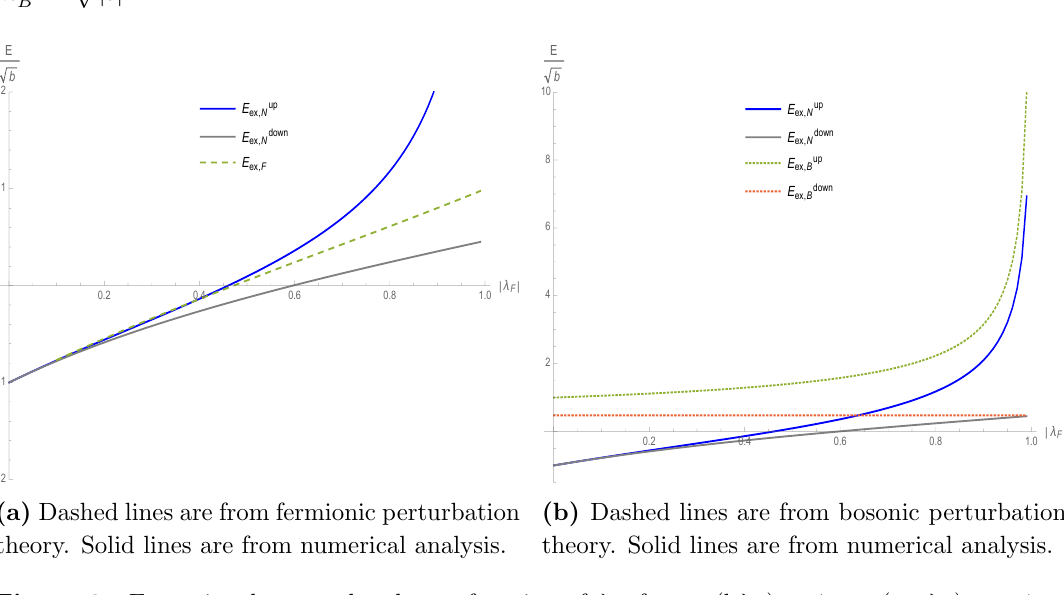
(a) Dashed lines are from fermionic perturbation theory. Solid lines are from numerical analysis. Figure 7. Exceptional energy band as a function of (cid:21) F for sgn(b (cid:21) F ) = (cid:0) 1, sgn(m F (cid:21) F ) = 1 at p m cri = j b j . B